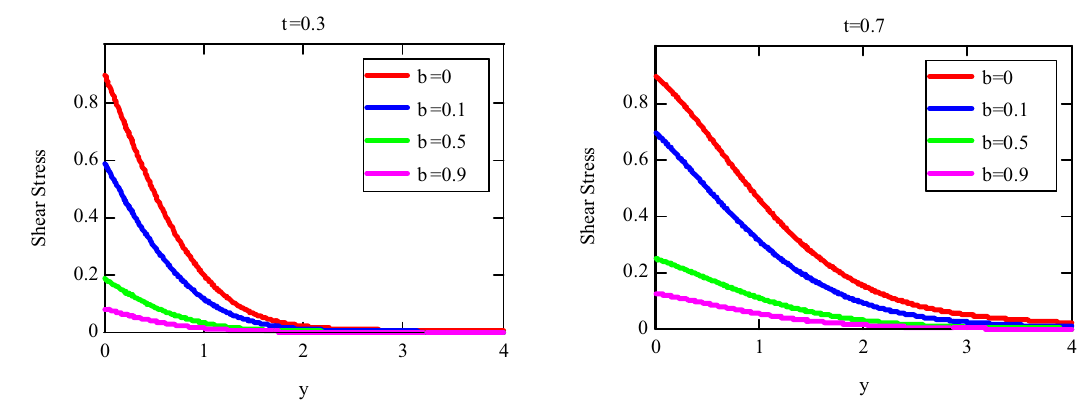
Figure 10: The shear stress pro fi le for variation of slip